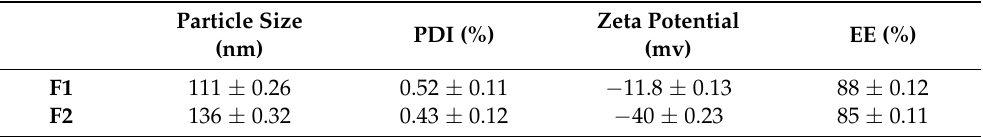
Table 5. Particle size, PDI, zeta potential, and entrapment efficiency (EE%) of the formulations of different CuSQ—loaded solid lipid nanoparticles